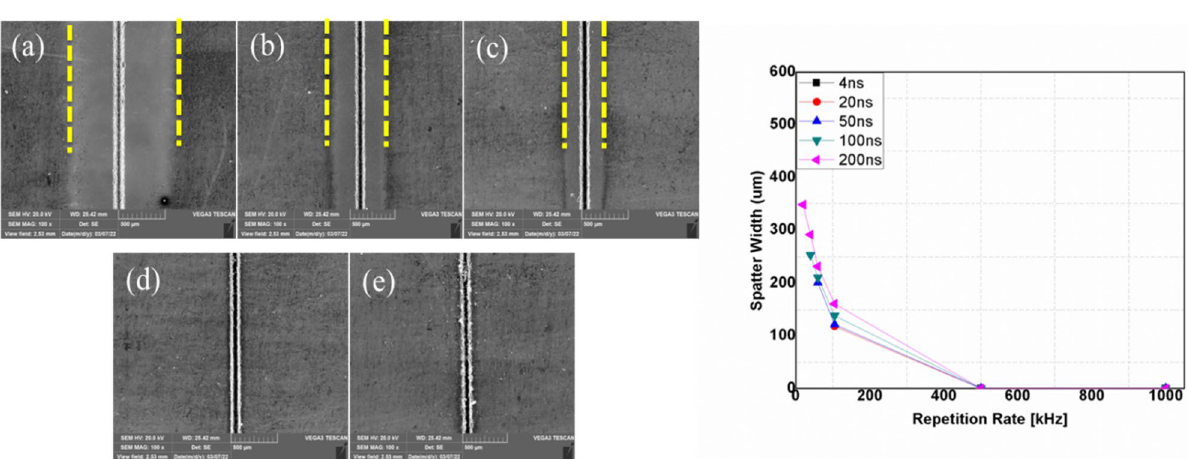
Figure 17. Chemical and hardness tests on cross-section—105 kHz.